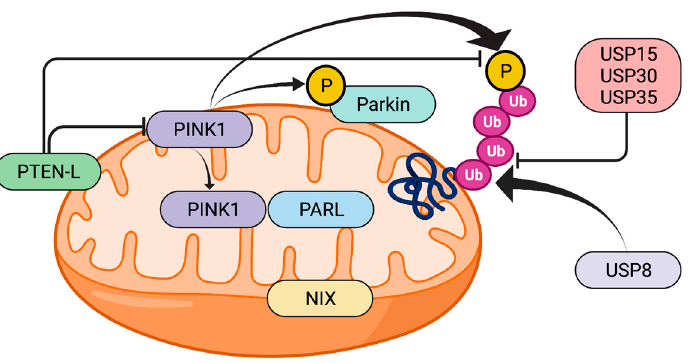
Figure 2. Schematic representation of PINK1-Parkin mitochondrial axis and some of the above- mentioned main potential therapeutic targets. PTEN-L, phosphate and tension homology deleted on chromosome ten-long; Ub, ubiquitin; USP, ubiquitin specific protease; NIX, Nip3-like protein X; PARL, presenilins-associated rhomboid-like protein. Created with